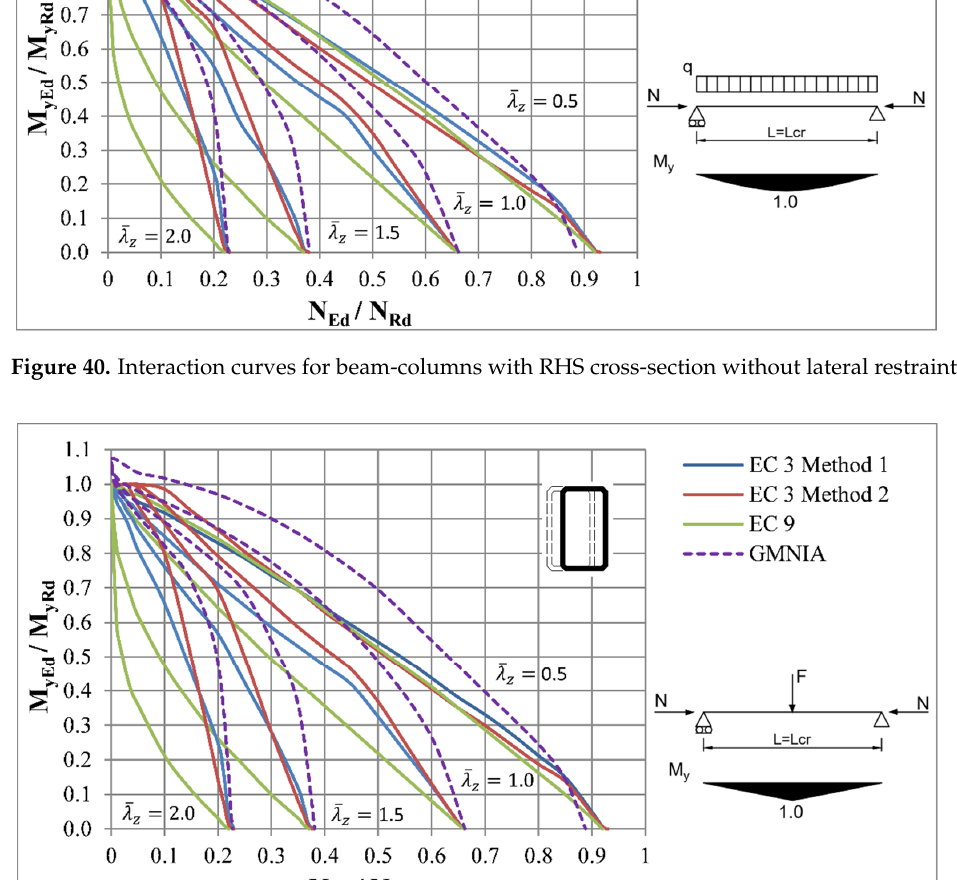
Figure 41. Interaction curves for beam-columns with RHS cross-section without lateral restraints.